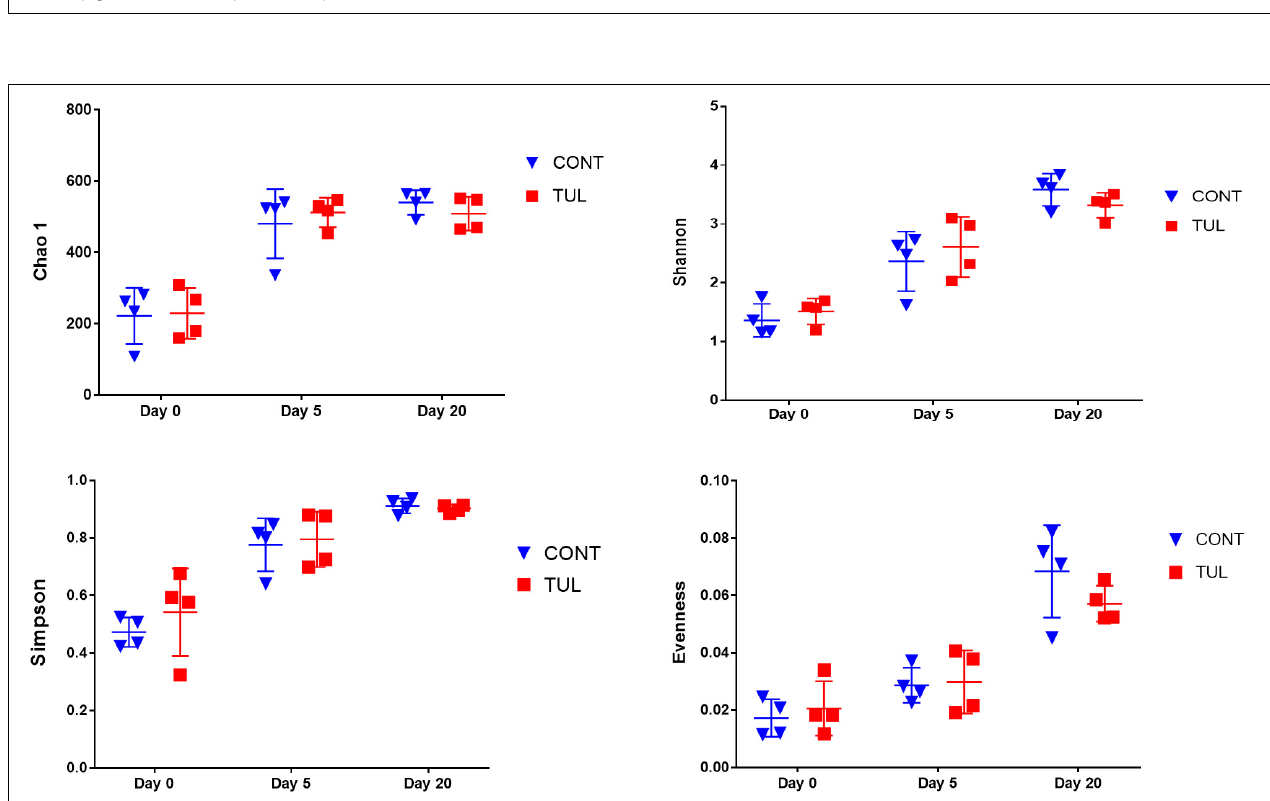
FIGURE 3 | Identification of indicator bacterial taxa associated with statistically significant differential abundance between the control (CONT) and tulathromycin (TUL) piglets at the different sampling days (0, 5, and 20). The top OTUs with the highest LDA score log10 ≥ 2.0 that discriminate between the CONT and TUL treated piglets at each time point are depicted.